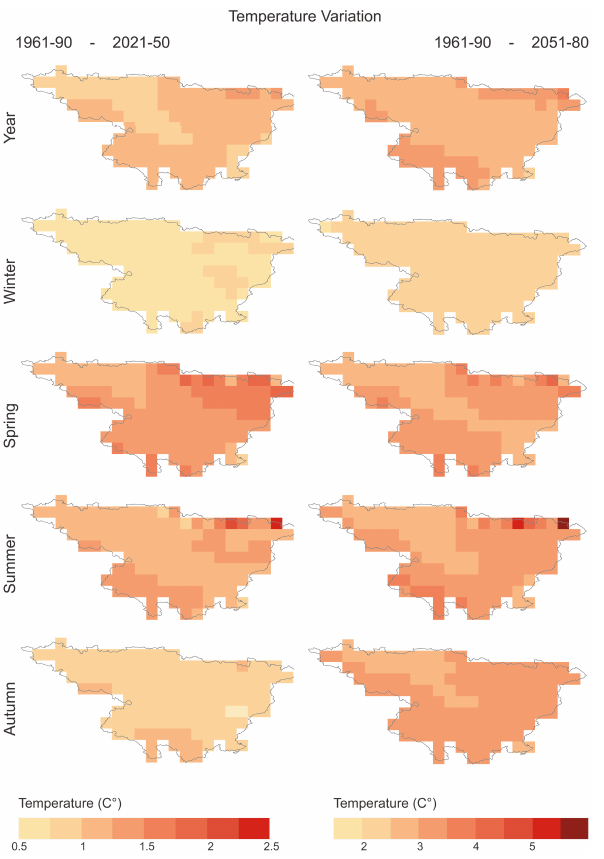
Fig. 9. Projected changes in precipitation under the HIRHAM5 model (A1B emission scenario) for the time slices 2021–2050 and 2051–2080 compared with the 1960–1990